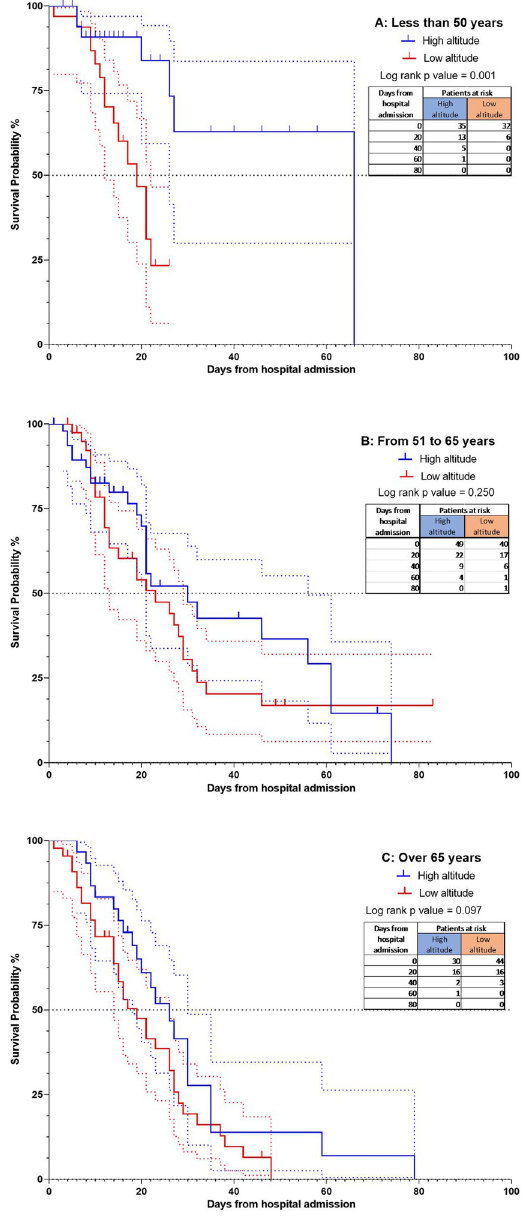
Fig 5. The Kaplan-Meier curves for mortality according to altitude and age categories. 5A Curve with age less than 50 years p = 0.001; 5B Curve with age from 51 to 65 years p = 0.250; 5C Curve with age over 65 years p = 0.097. All comparisons were calculated with COX regression multivariate